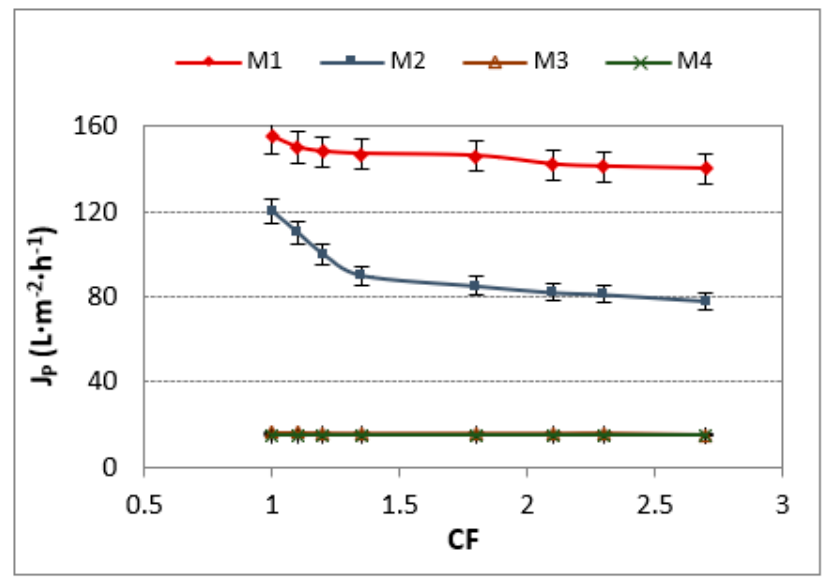
Figure 7. Influence of concentration factor (CF) on permeate flux.